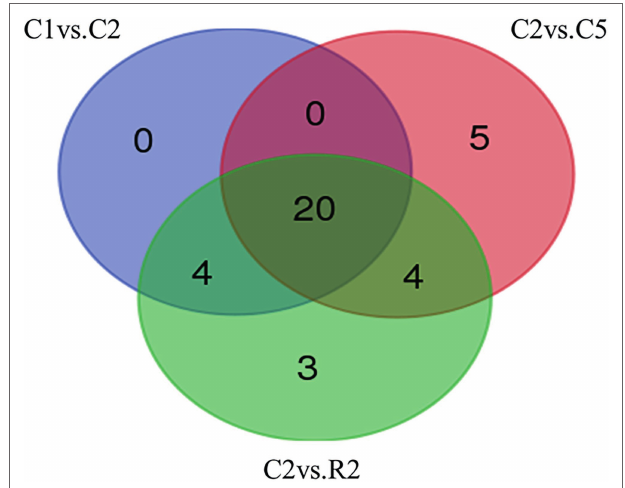
FIGURE 6 | Venn diagram of miRNAs found in DEG sets C 1 vs. C 2 , C 2 vs. C 5, and C 2 vs. R 2. Among all the comparison sets, 20 miRNAs were found to be